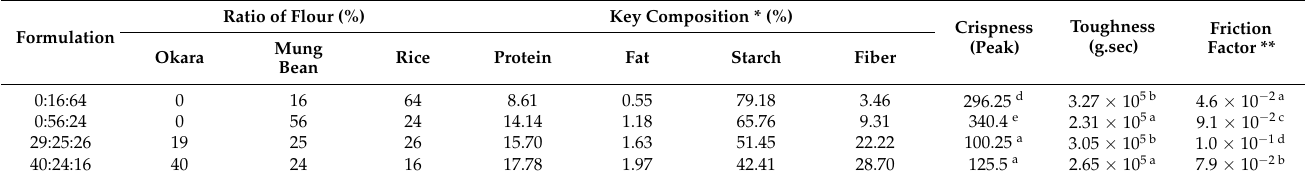
Table 4. Snack formulation, ratio of flour, and chemical composition and instrumental texture and friction